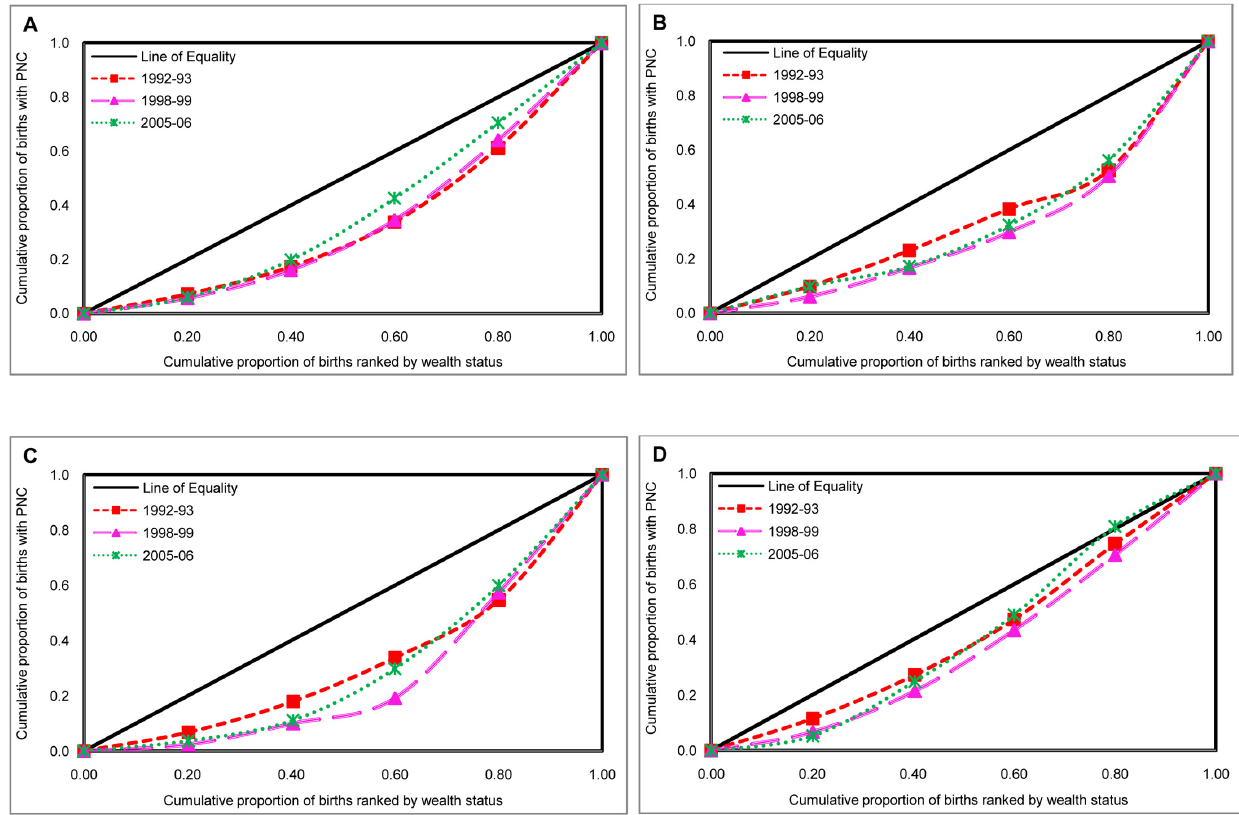
Figure 2. Concentration curves showing inequalities in prenatal care (PNC) by economic status of population across states, India, 1992–2006. A [INDIA] . B [UTTAR PRADESH] . C [MAHARASHTRA] . D [TAMILNADU] . X axis=Cumulative proportion of births ranked by wealth status. Y axis=Cumulative proportion of births with prenatal care (PNC). Red square=Concentration curve for 1992–93. Pink triangle=Concentration curve for 1998–99. Green cross=Concentration curve for 2005–06.